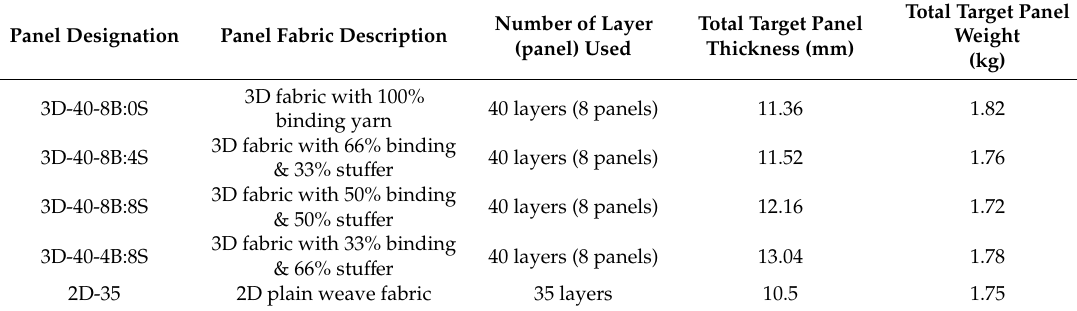
Table 2. Specification of target panels made of 2D plain weave and the produced 3D warp interlock high-performance para-aramid fabrics (*3D-40-8B:0S are expresses as 3D-3D warp interlock fabric,